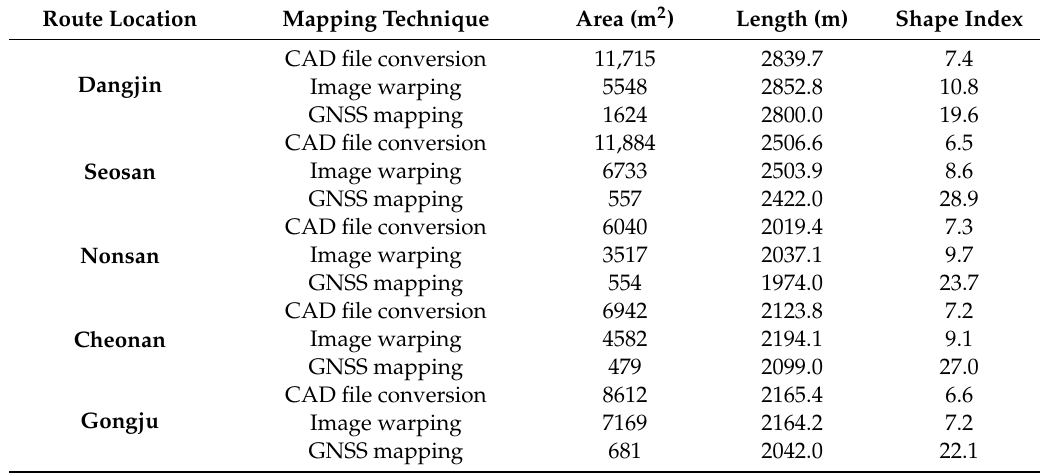
Table 4. The shape index by mapping technique.